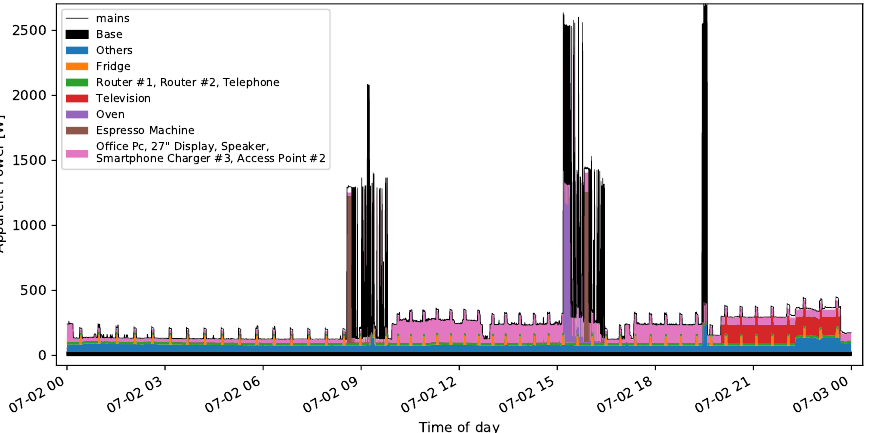
Figure 13. The power consumption of the apartment over one full day (2nd July 2020). The power is down-sampled to one sample every 3s. The black line indicates the power consumption recorded by the SmartMeter. The contribution of the six top-most consumers is shown as stacked colored blocks. The consumption of all remaining appliances and the reconstructed consumption of the apartment’s lighting are aggregated and shown as the blue block others . The black base block represents the apartment’s base power estimated as 26.66VA on average for this